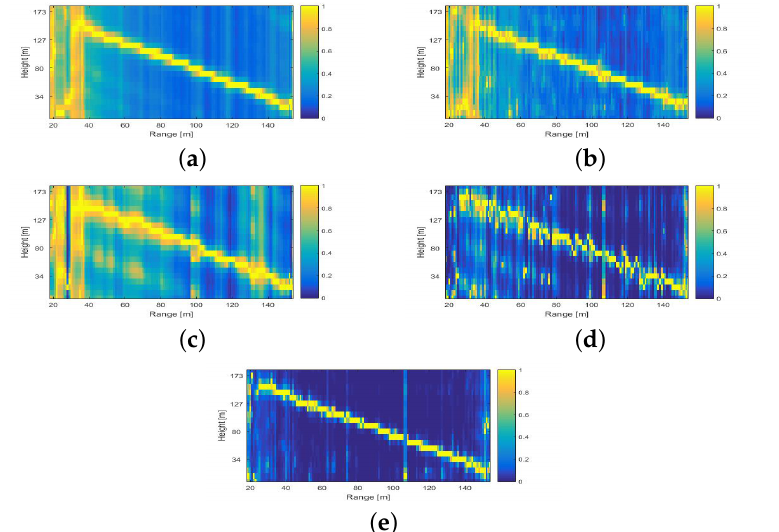
Figure 8. Tomograms of the blue azimuthal line generated by the ( a ) Standard MUSIC estimator, ( b ) BIC-MUSIC estimator, ( c ) Minimum-Norm estimator, ( d ) Regularized Minimum-Norm estimator, and ( e ) proposed non-parametric MUSIC estimator.